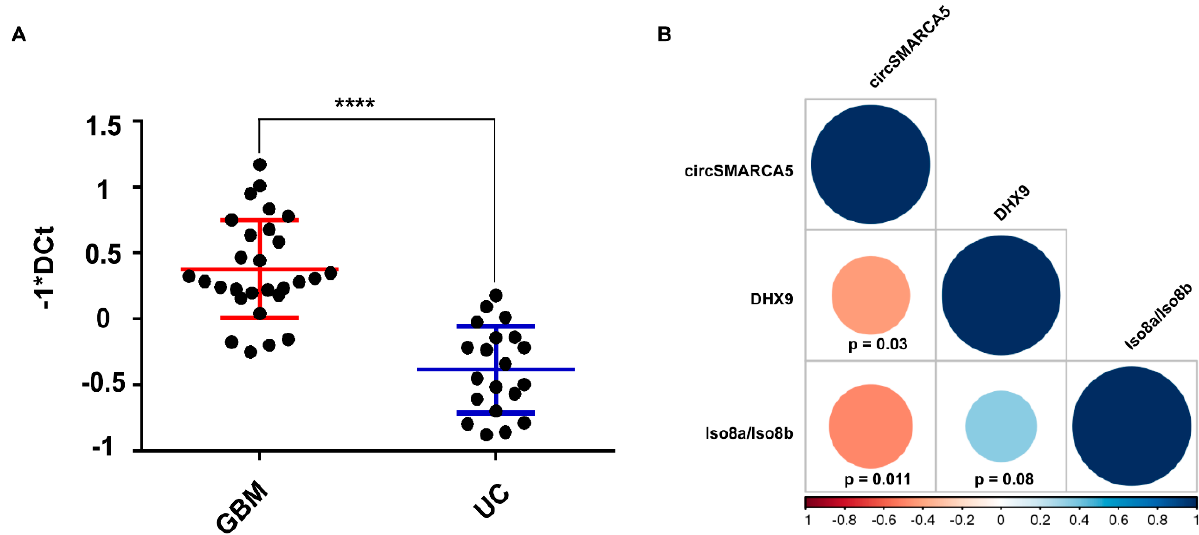
Figure 6. DHX9 mRNA is upregulated in GBM tumor biopsies and its expression negatively correlates with that of circSMARCA5. ( A ) Column scatter dot plot graph representing the expression of DHX9 mRNA in a cohort of GBM tumor biopsies ( n = 28) and unaffected brain parenchyma (UC) ( n = 20) (**** p -value < 0.0001, Student’s t -test). Expression data are represented as − 1*DCt (the higher the value, the higher the expression of DHX9 mRNA; vice versa, the lower the value, the lower the expression of DHX9 mRNA). TBP mRNA was used as endogenous control to calculate ∆ Ct. ( B ) Matrix of correlations among the expression of DHX9 mRNA, circSMARCA5, and Iso8a to Iso8b VEGFA mRNA isoform ratio (Iso8a/Iso8b). Blue and red color indicate positive and negative correlations, respectively. Correlation coefficients (r-values) are shown in the color scale bar. Size of the circle and their color intensity are proportional to the r-values in the correlation matrix.